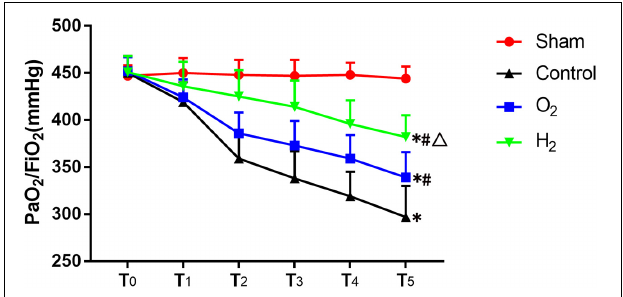
FIGURE 2 | The indices of PaO 2 /FiO 2 in each group ( n = 8). Values are mean values ± standard deviations. T 0 –T 5 represented the following time points: baseline before transplantation, and 3, 30, 60, 90, and 120 min after reperfusion. PaO 2 /FiO 2 , partial pressure of arterial oxygen (PaO 2 )/fraction of inspired oxygen (FiO 2 ). ∗ P < 0.05 vs. sham group; # P < 0.05 vs. control group; (cid:77) P < 0.05 vs. O 2 group.